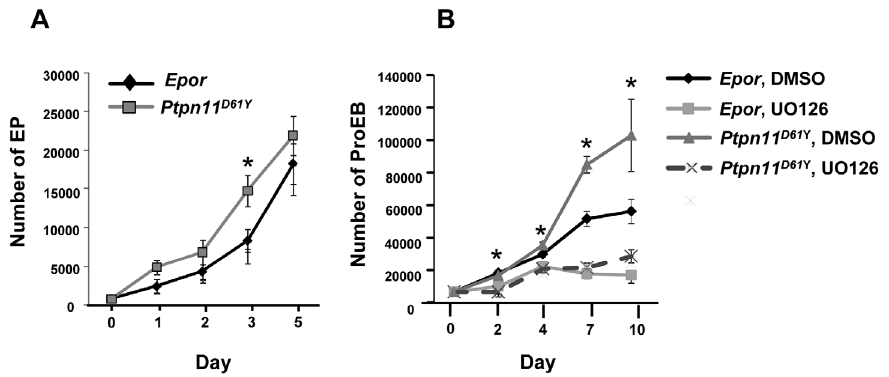
Figure 4. Ptpn11 D61Y erythroid progenitors show defective differentiation invitro . (A) BM-derived Lin 2 cKIT + cells from Epor and Ptpn11 D61Y mice were FACS-purified and cultured in serum-free StemEx medium for 5 days, as described in Materials and Methods. Absolute numbers of cells were determined daily. The average number of cells from four independent experiments is shown. * p # 0.05, ANOVA. (B) Lin 2 cKIT + cells from Epor and Ptpn11 D61Y mice were FACS-purified and cultured in serum-free StemEx medium 7 days. Equal numbers of cells were expanded in StemEx medium for another 10 days in the presence of UO126 or DMSO. The average number of cells from three independent experiments is shown. * p # 0.05, ANOVA.